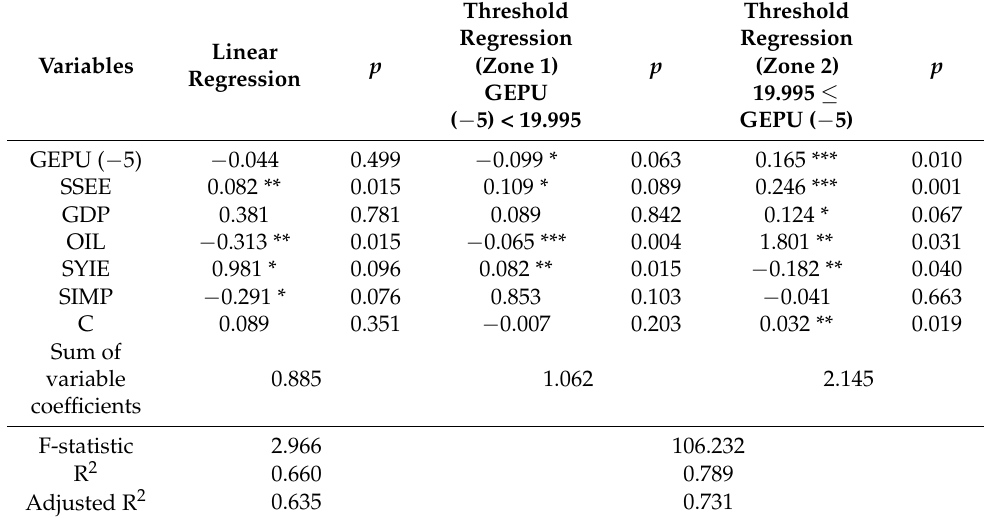
Table 5. Soybean price model regression results.